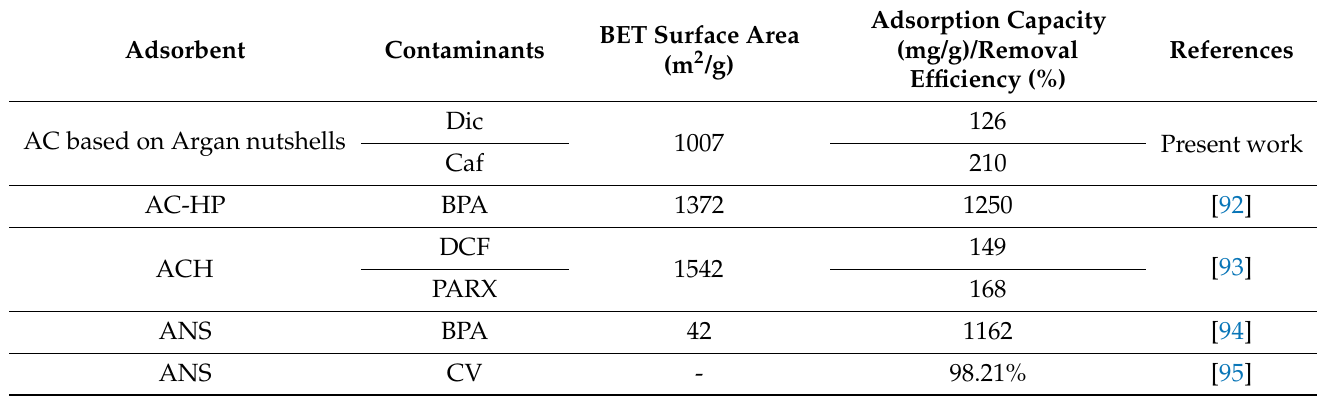
Table 6. Adsorption capacities and surface area of different contaminants using AC based on argan fruits shells compared to the literature